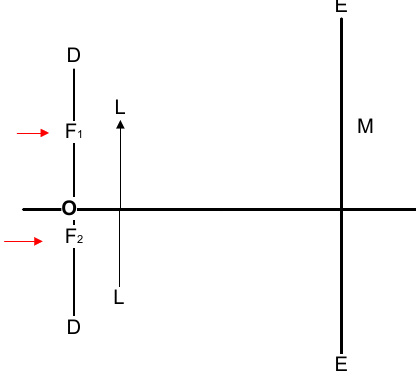
Figure 2. Diffraction of a corpuscular beam by two slots.